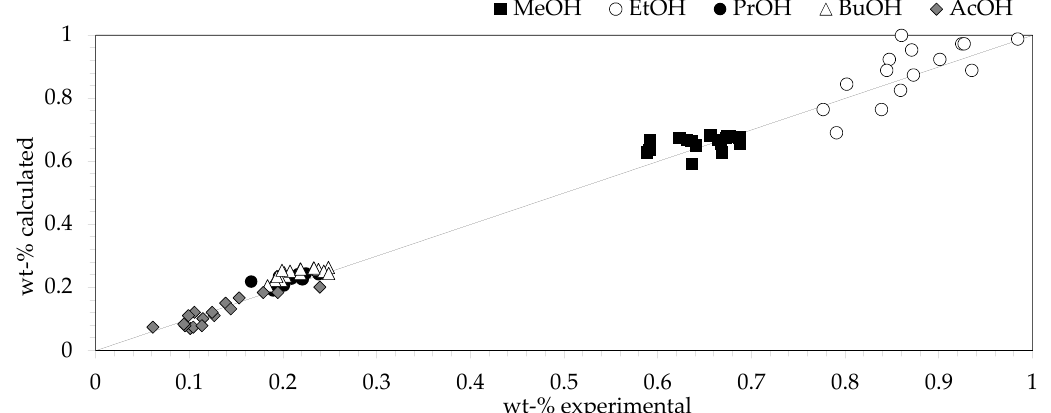
Figure 2. Parity plots of MeOH (full cubes), EtOH (empty spheres), PrOH (full spheres), BuOH (empty triangles), and AcOH (full diamonds) concentrations.